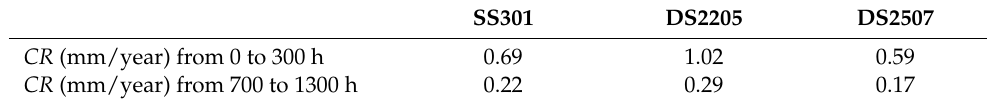
Table 3. Corrosion rates ( CR ) of tested steels in molten carbonate salts at 600 ◦ C for each alloy. SS301